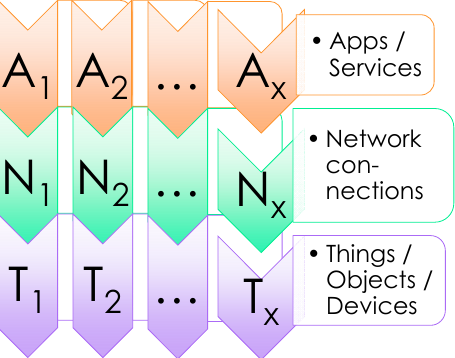
Figure 1. Schematic of the vertical architectural design approach for the creation of IoT platforms.